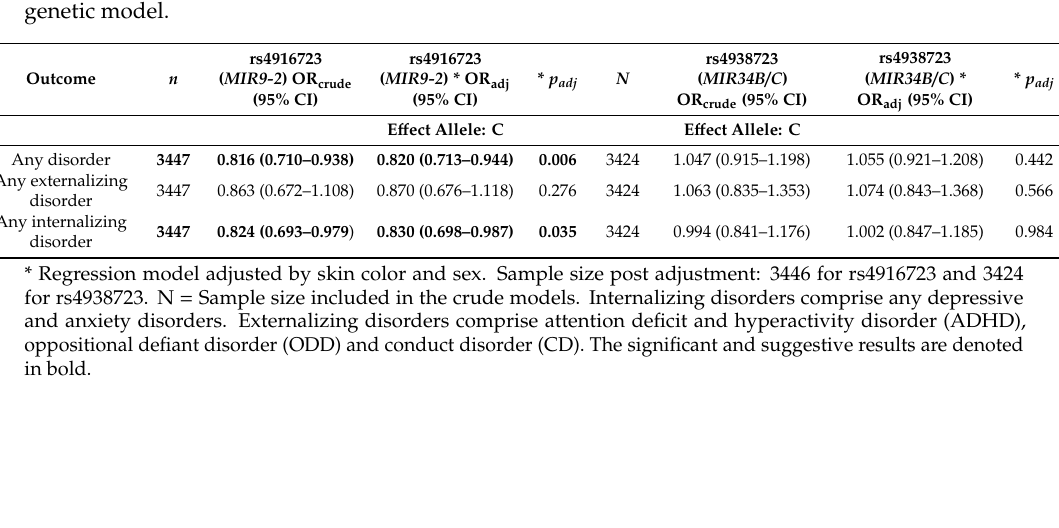
Table 2. Association analysis between single nucleotide polymorphisms (SNPs) and mental health outcomes at six years of age using logistic regression (crude and adjusted models) and an additive genetic model.